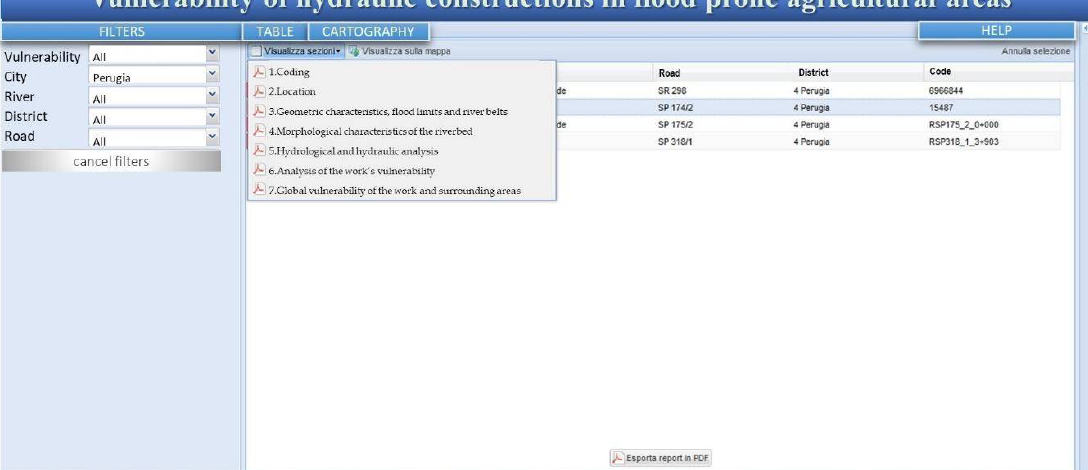
Figure 12. Map detail of the urban context in which the structure is located.